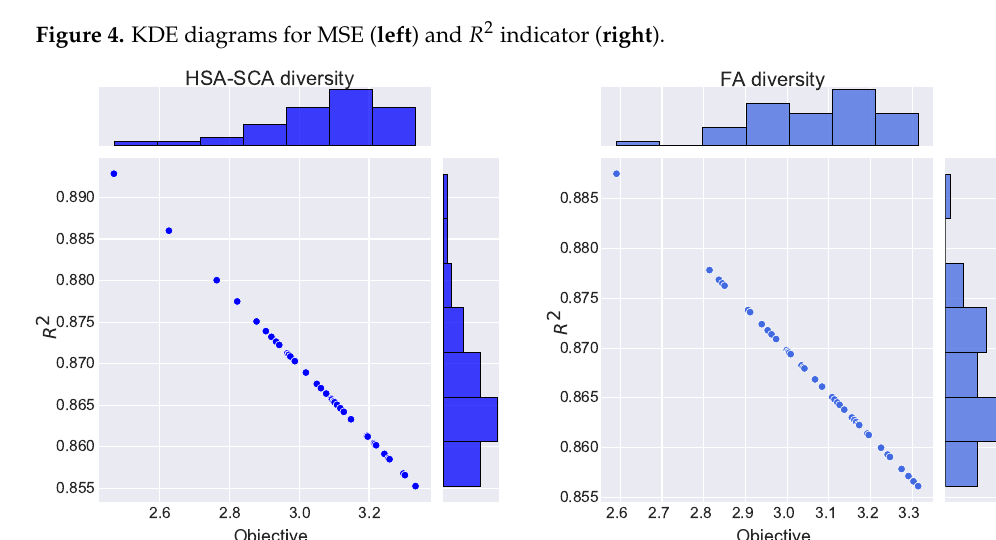
Figure 5. Join plots with histograms of two best methods: HSA-SCA ( left ) and FA ( right ). Finally, the visualizations of the best-predicted outcomes attained by the best-produced model by four best algorithms is shown in Figure 6. Once more, it can be concluded that the model optimized by the HSA-SCA algorithm produced the best predictions for the observed problem.